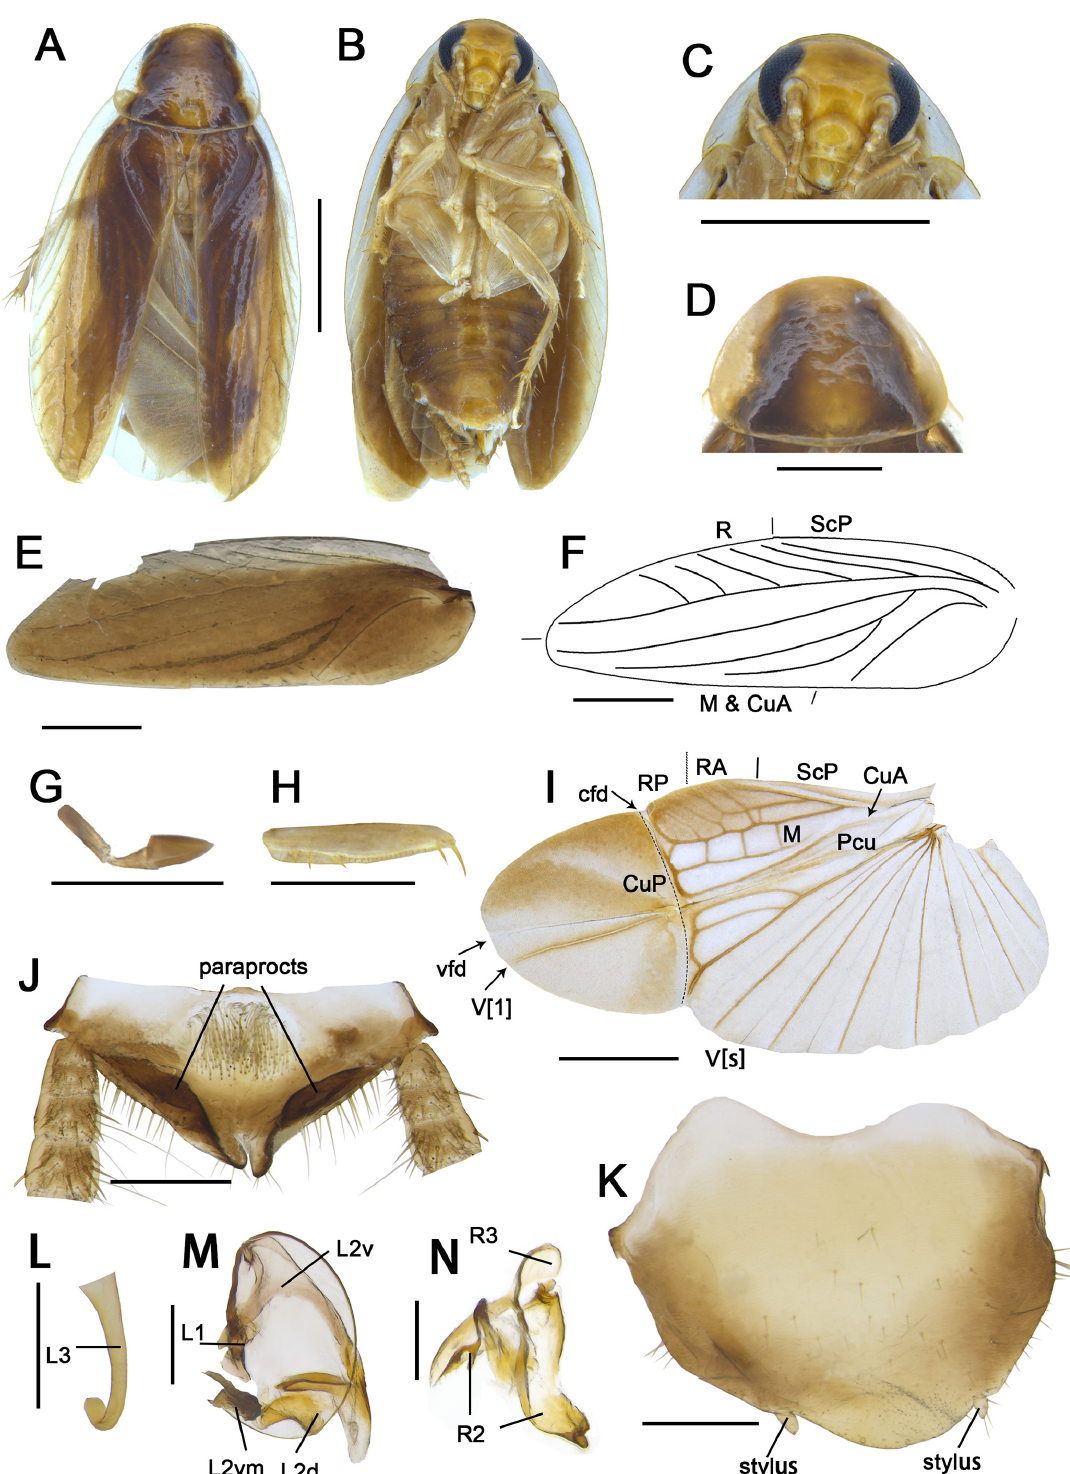
Fig. 5. Anaplecta strigata Deng & Che sp. nov., holotype, ♂ (SWU). A . Habitus, dorsal view. B . Habitus, ventral view. C . Head, ventral view. D . Pronotum, dorsal view. E . Tegmina. F . Tegmina vein. G . Maxillary palp. H . Front femur, ventral view. I . Wings. J . Supra-anal plate, dorsal view. K . Subgenital plate, ventral view. L . Hook, ventral view. M . Left phallomere, ventral view. N . Right phallomere, ventral view. Scale bars: A–B = 2 mm; C, E–F, I = 1 mm; D, G–H, J–K, M–N = 0.5 mm; L = 0.25